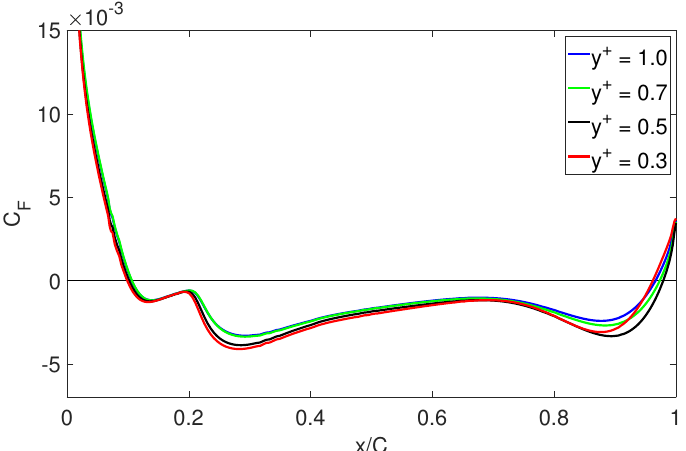
Figure 7. Baseline case friction coefficient comparison.